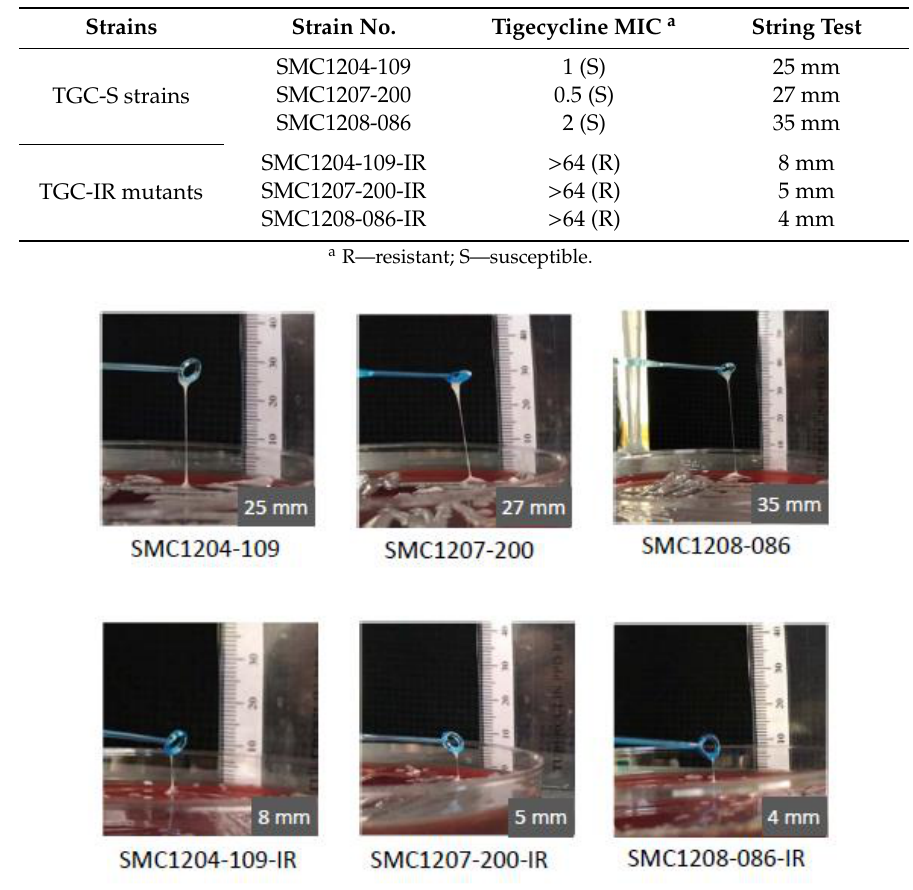
Figure 1. Results of string tests. Comparison of stretched colonies between TGC-S and TGC-IR K. pneumoniae strains. Generally, a string 5 mm or longer was defined as positive.